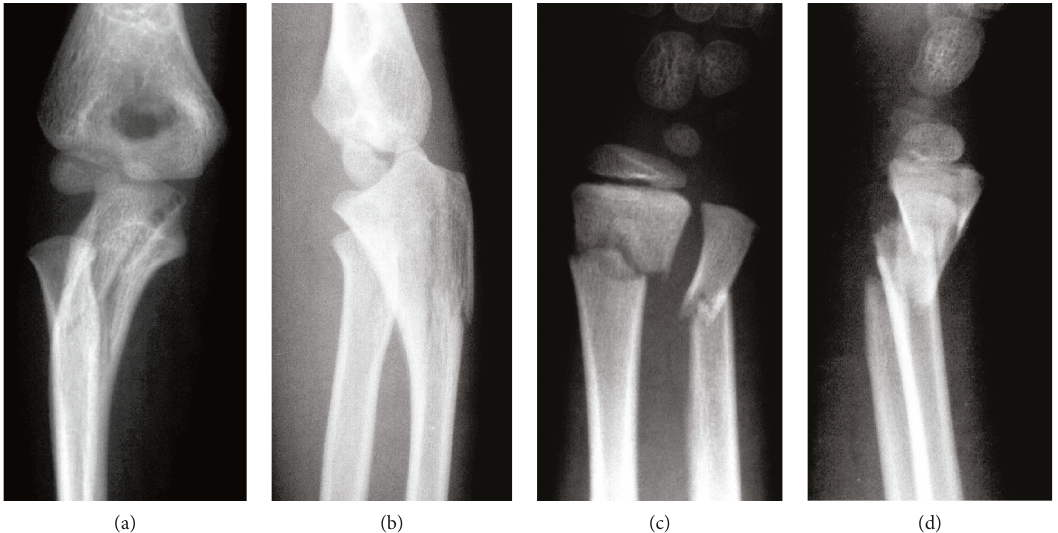
Figure 2: X-rays images after manual reduction. (a) AP view of the elbow joint showing subluxation of the radial head. (b) Lateral view of the elbow joint. (c) Front view of the wrist joint showing dislocation of the distal radius. (d) Lateral view of the wrist joint showing dislocation of the distal